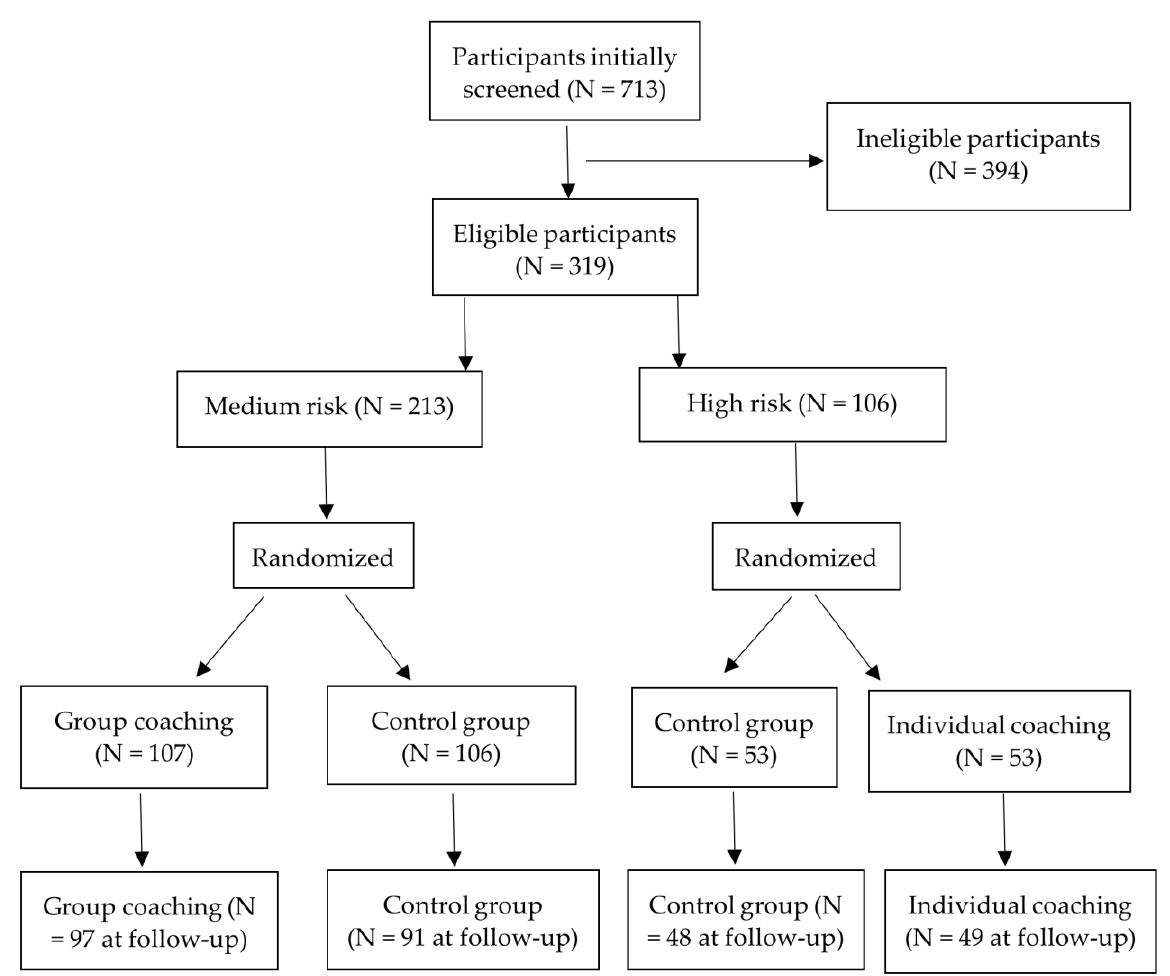
Figure 1. Flow chart of the study population.